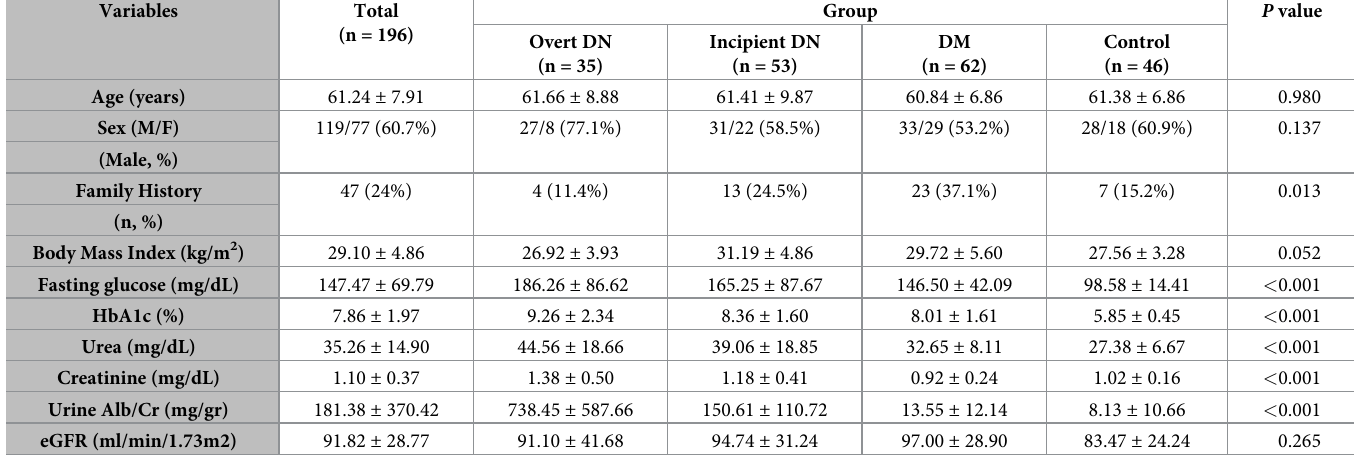
Table 1. Demographic and clinical laboratory characteristics.